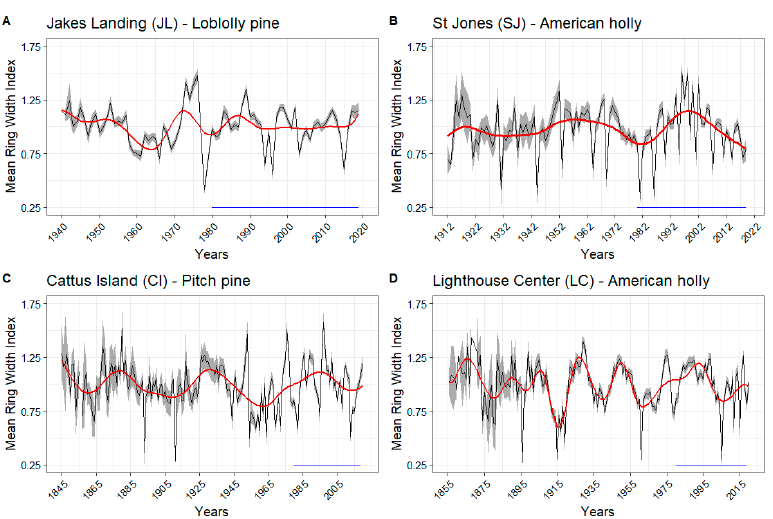
Figure 3. Mean chronologies for ( A ) Jakes Landing loblolly pines, ( B ) St. Jones American hollies, ( C ) Cattus Island pitch pines, and ( D ) Lighthouse Center American hollies. Mean chronologies (black line) with splines (red line) are bounded by standard error (light grey). The blue horizontal line in the bottom right of each graph shows the extent of the water level records (and therefore, the extent of the climatic data used in correlations), which was 1980–2019. Table 2. Summaries of chronologies developed for each site, including site, species, number of cores ( n ), mean diameter at breast height (DBH, in cm ± standard deviation (sd)), mean chronology length (in years ± sd), interseries correlation, and sensitivity.